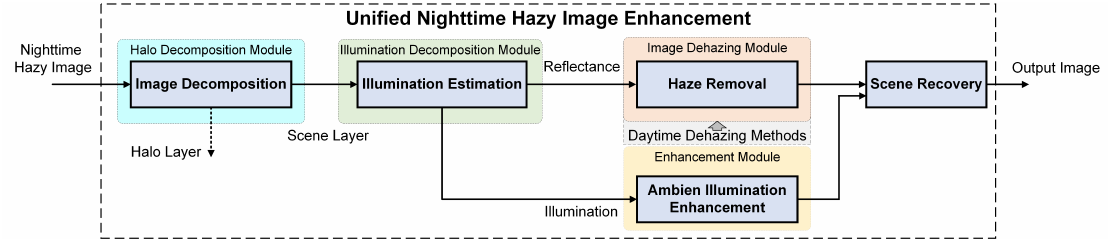
Figure 1. Framework of the proposed SImultaneously Dehazing and Enhancement of nighttime hazy images